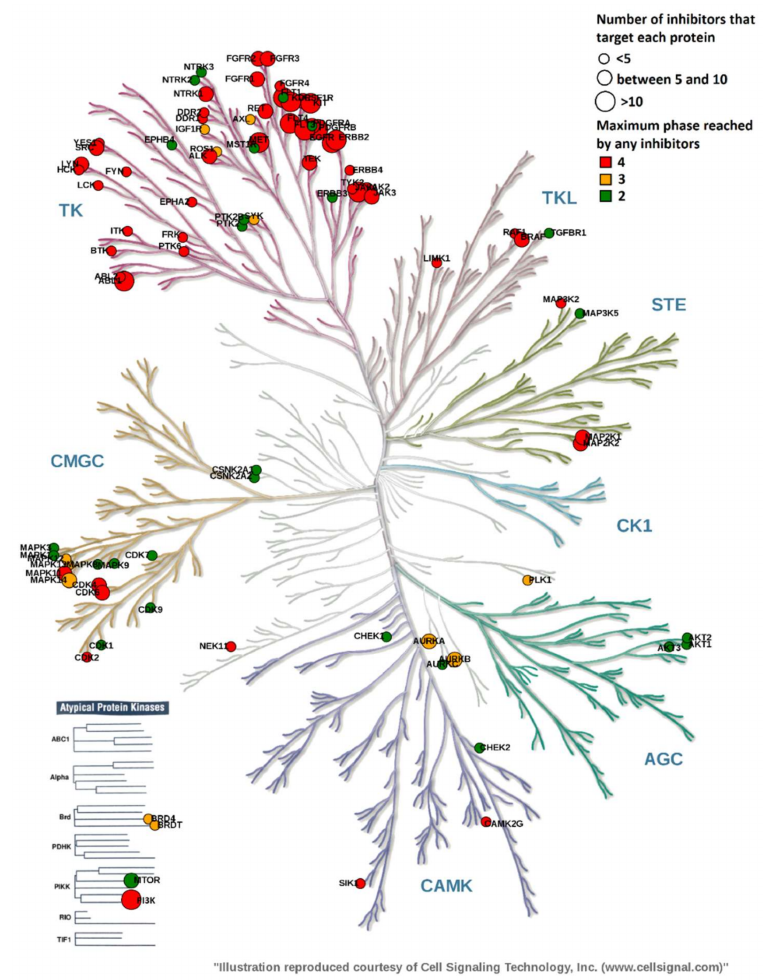
Figure 8. Kinome tree exploring the protein kinase space. The maximum phase reached by an inhibitor is color-coded: phase 4 (red), phase 3 (orange) and phase 2 (green). The size encodes the number of PKIs per protein kinase: small size encodes a number of inhibitors less than 5, medium size encodes a number of inhibitors between 5 and 10 and large size encodes a number of inhibitors greater than